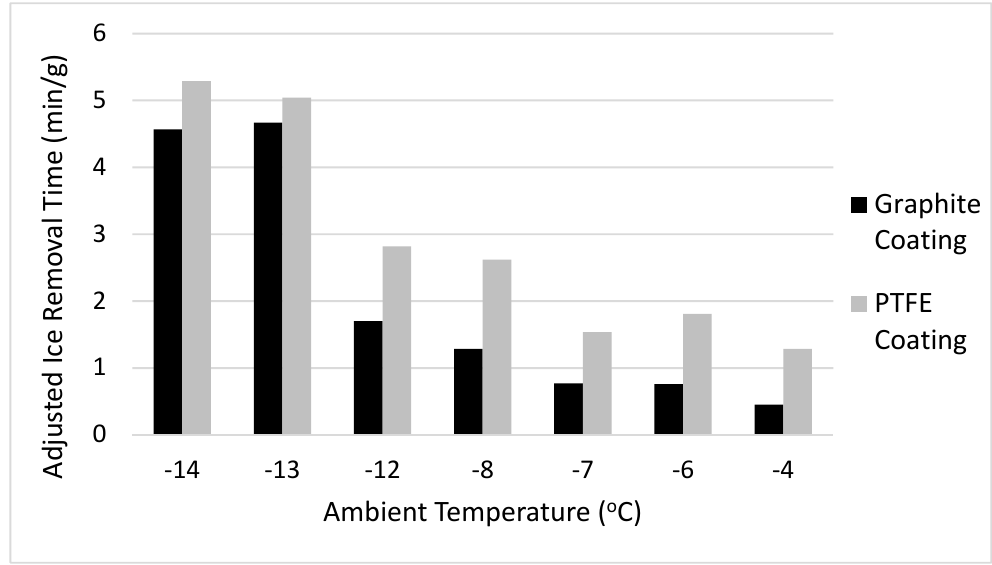
Figure 8. Adjusted ice removal time vs. test section temperature.